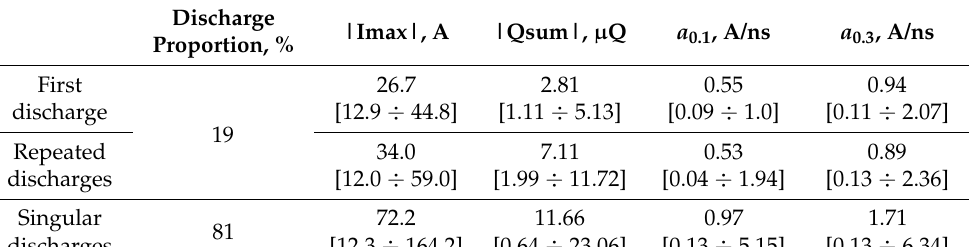
Table 2. Parameters of main stage discharge current pulses from a single artificial thunderstorm cell of positive polarity, involving two groups of model hydrometeors (mean value, range).